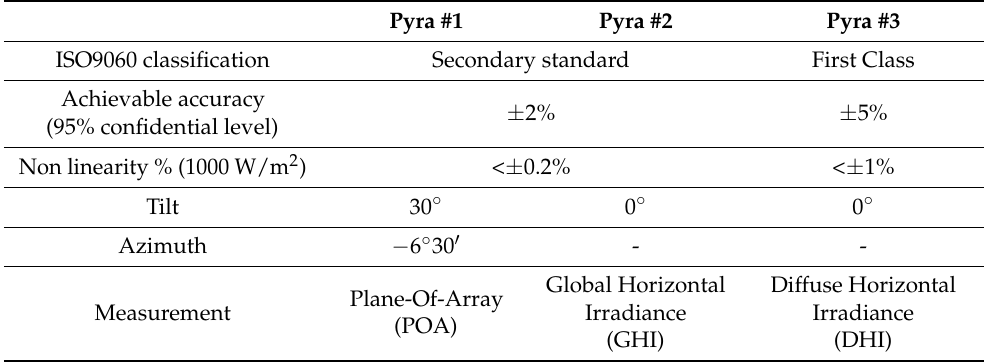
Figure 8. SolarTech Lab weather station. Table 1. Technical specifications of pyranometers connected to the weather station and available in the test